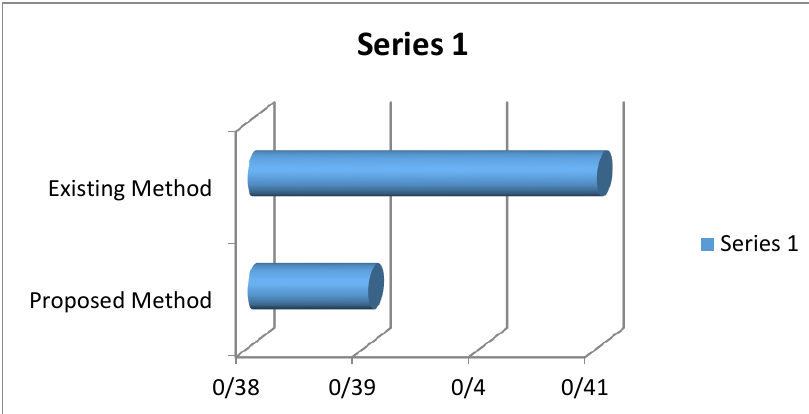
Fig. 2. Graphical analysis of proposed work with existing work of example